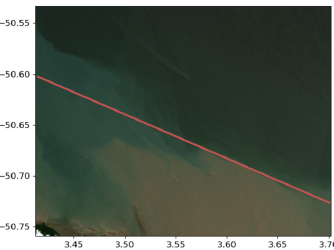
Figure 9. Example image of the test area in French Guiana showing the edge of high water